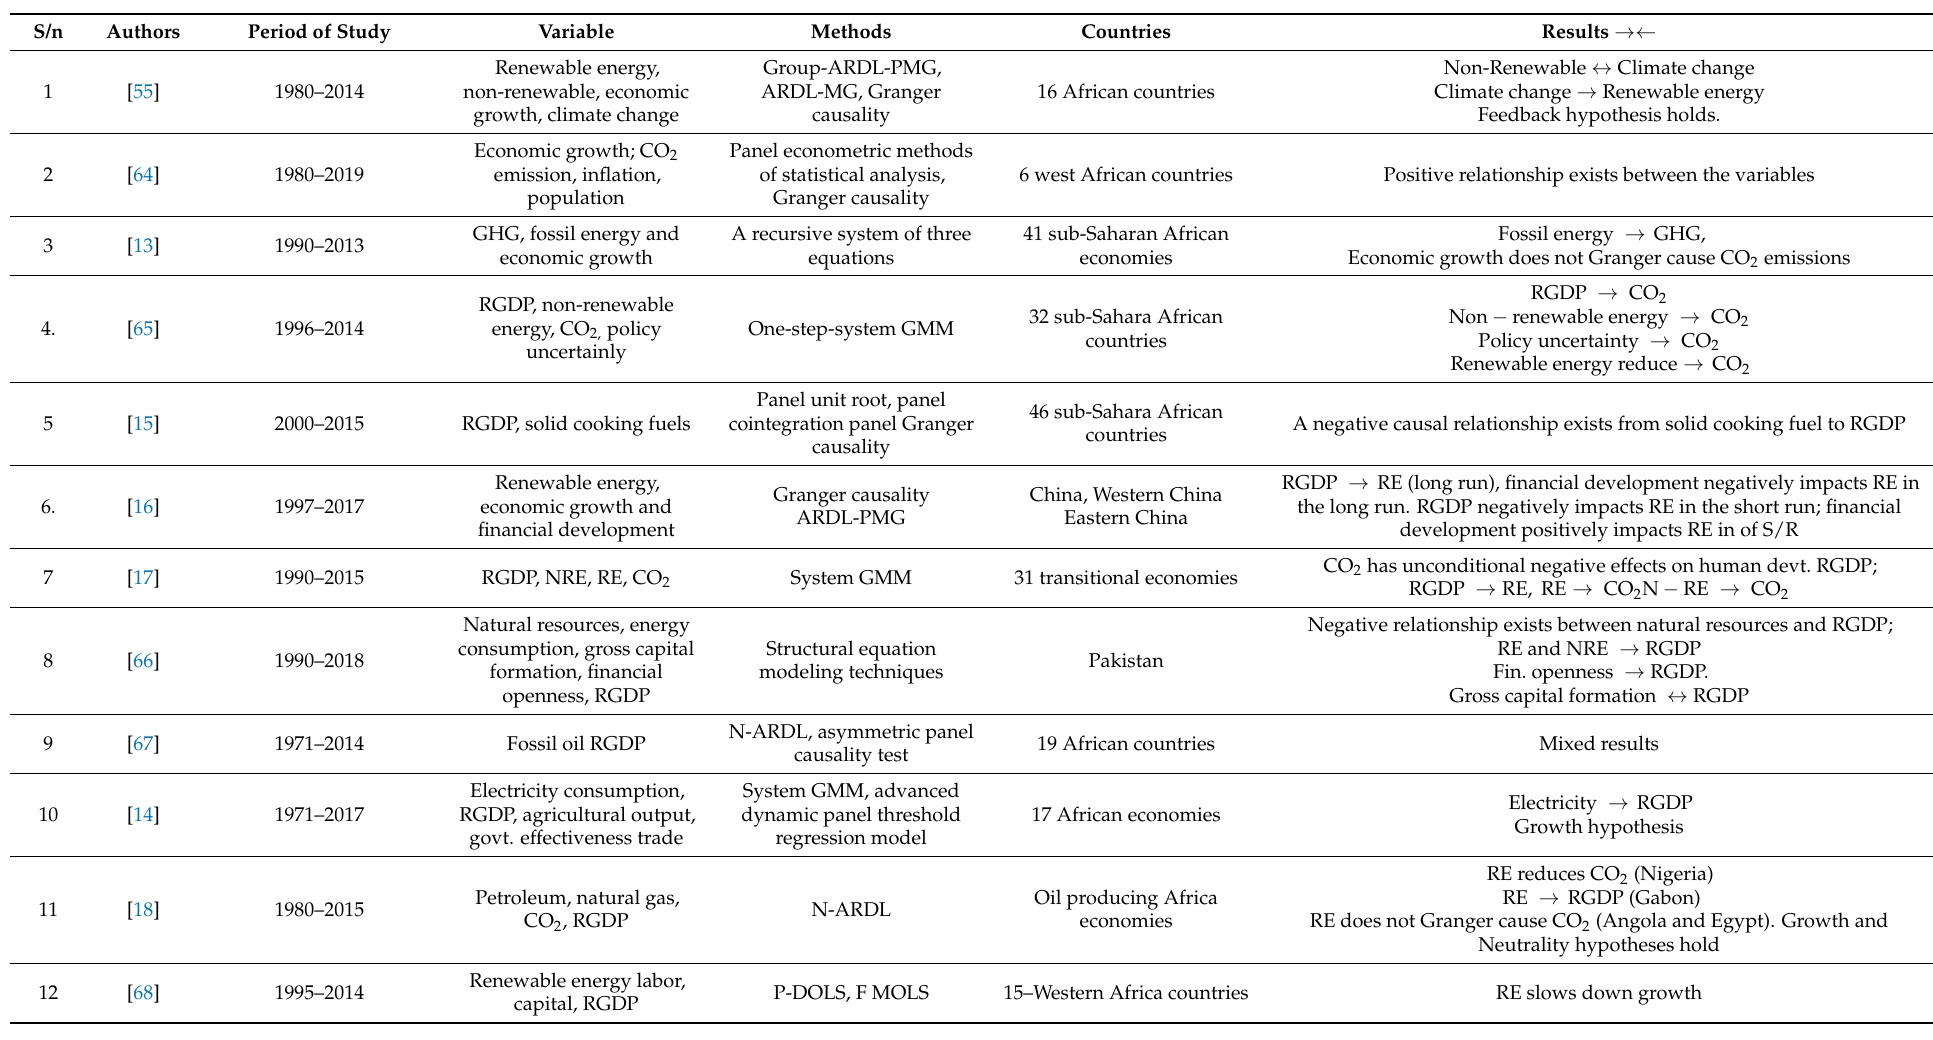
Table 1. Summary of Literature